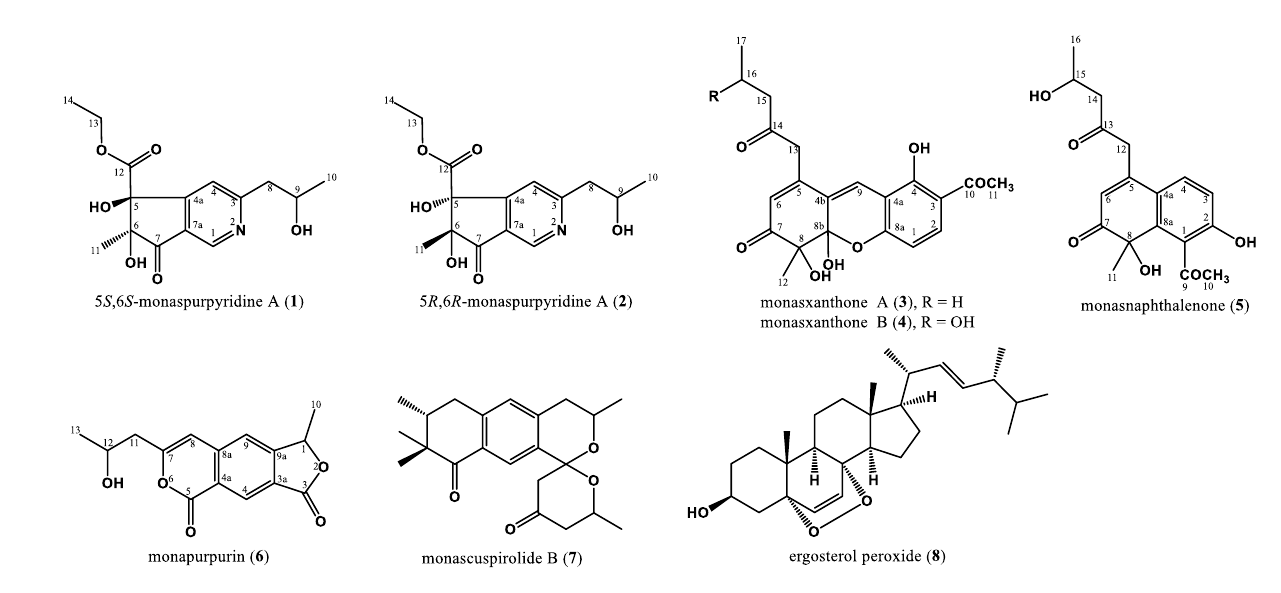
Figure 1. Structures of compounds 1 ‒ 8.